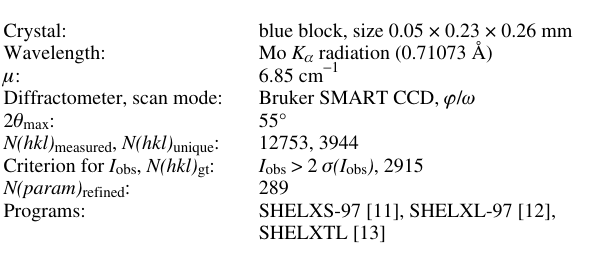
Table 1. Data collection and handling.